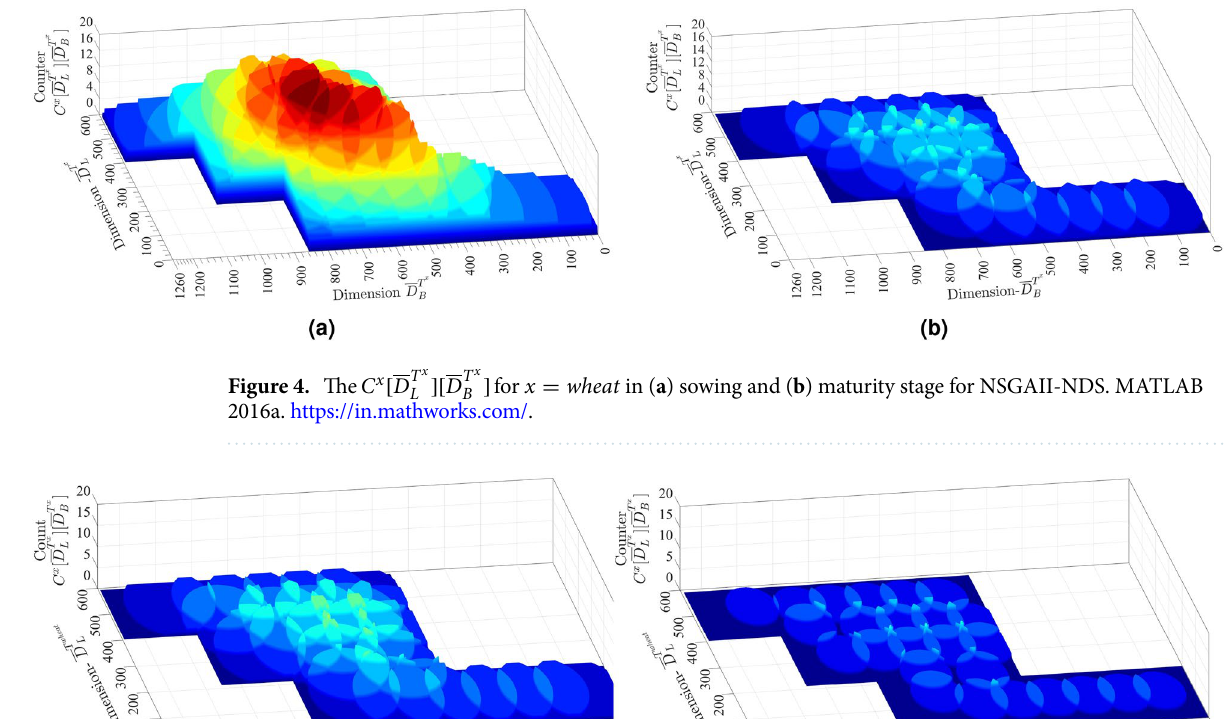
Figure 5. The C x [ D mathw orks.